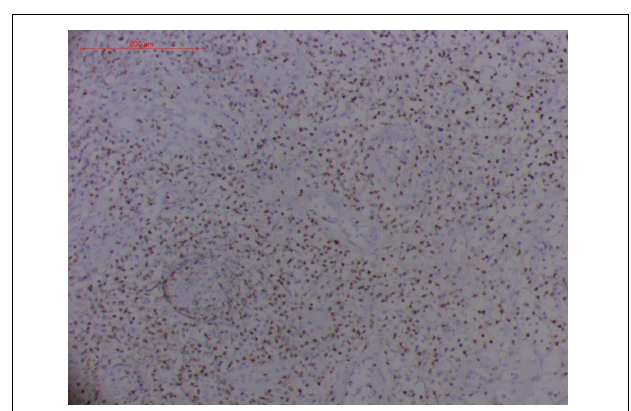
FIGURE 14 | Extranodal natural killer/T cell lymphoma, nasal type/rhino-orbital-cerebral mycosis.” Rhizopus arrhizus -induced positive expression of TIA1 from granulomatous tissues (envision method, original magnification ×